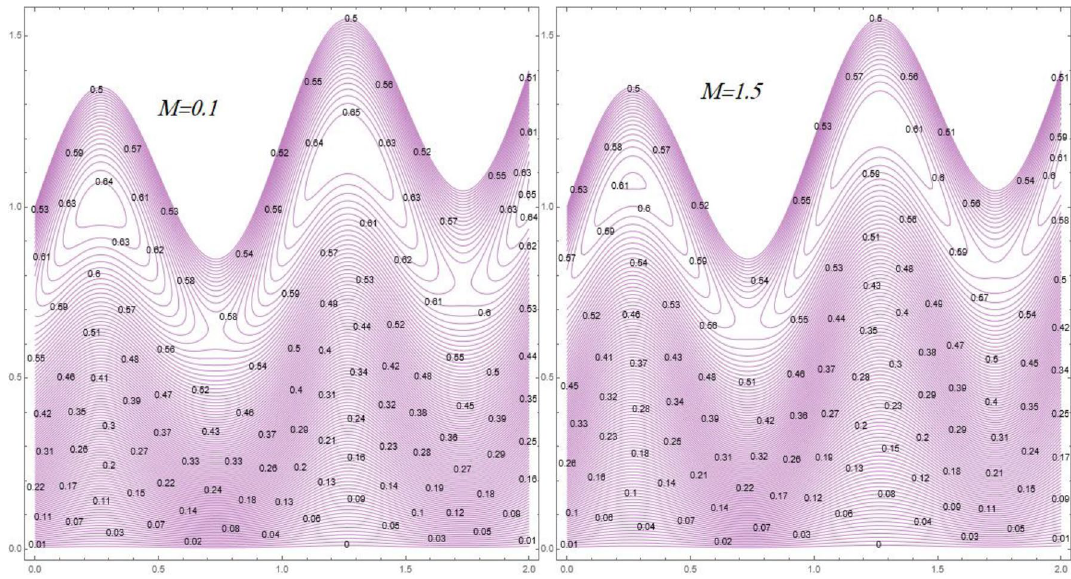
Figure 12. Streamlines behavior against different values of Hartmann number ( M ) .